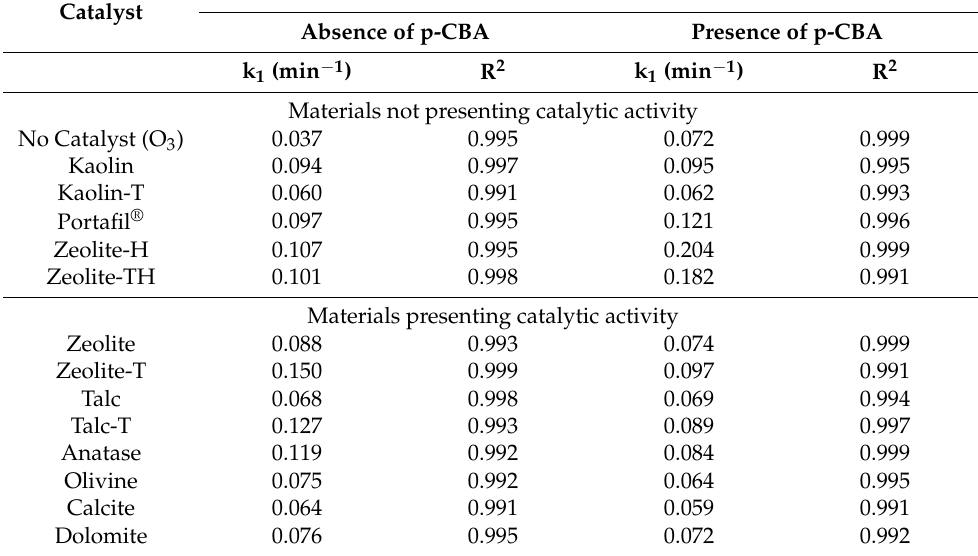
Table 1. Values of first-order kinetic parameters for O 3 decomposition with and without the addition of p-CBA in the catalytic ozonation process. Experimental conditions: initial p-CBA concentration 4 µ M (when added), O 3 concentration 2 mg/L, catalyst concentration 0.5 g/L, pH 7, temperature 23 ± 2 ◦ C, reaction time 30